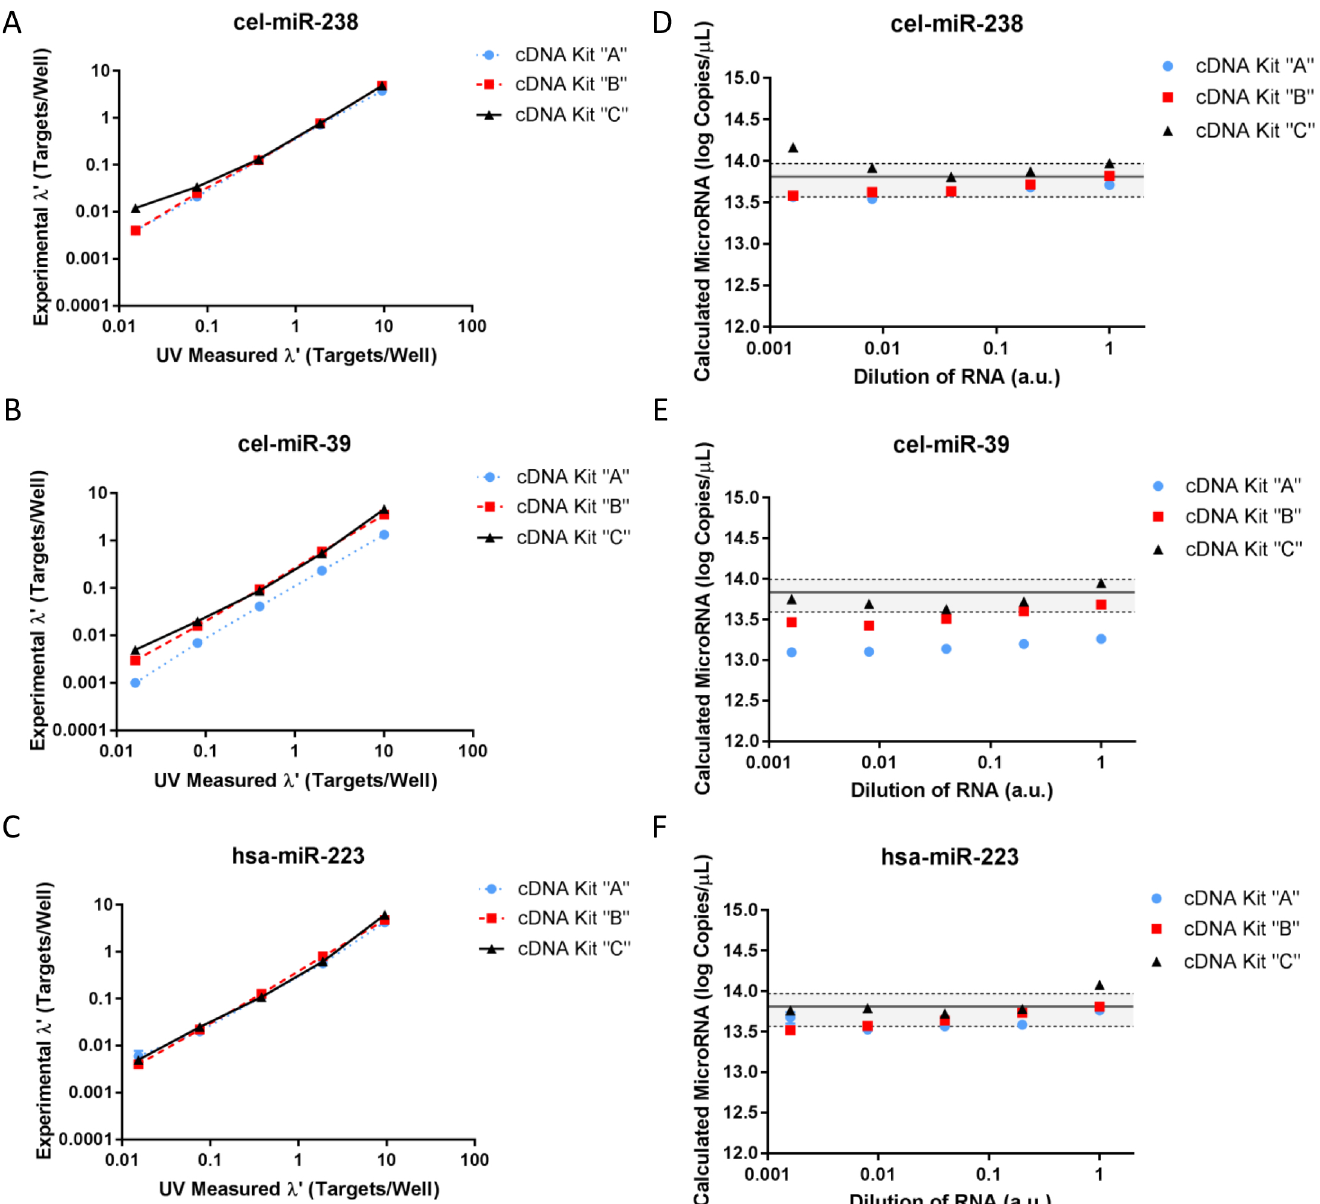
Fig 5. miRNA titration curves. All synthetic oligonucleotides were combinedinto a target master mix and subsequently diluted prior to cDNA synthesis. cDNA master mix was minimallydilutedprior to ddPCRquantification. Values were normalized by subtracting averageNTC and NEC from total positive dropletsper kit. All three cDNA synthesis kits, “A”, “B”, and “C” graphs were organized by three targets: (A, D) cel-miR-238, (B, E) cel-miR-39, or (C, F) hsa-miR-223. cDNA synthesis kits were used to synthesize cDNA and data were plotted as (A to C) UV measuredas determined by dilutionfactor times UV measuredversus normalizedexperimental targets per well. (D to F) Normalizedtargets per well were extrapolatedto miRNA copies/ μ Lby multiplying by droplet volume, cDNA dilutionfactor, miRNA dilution factor, dilutioninto master mix, and molecularweight. The predicted copies of miRNA (Table 2) is shown as a black line. Gray shadingindicatesthe 95% coverageinterval for predicted miRNA copy number. miRNA dilutionsare reportedin arbitrary units and correspondto 1 × , 0.2 × , 0.04 × , 0.008 × ,and 0.0016 × .The standarduncertaintyis shown for each point, a result of three technicalreplicatesfor one experiment. Graphs are shown as log-logscale for visualization; they were developedusing GraphPad Prism. Statics were estimated using RStudio.